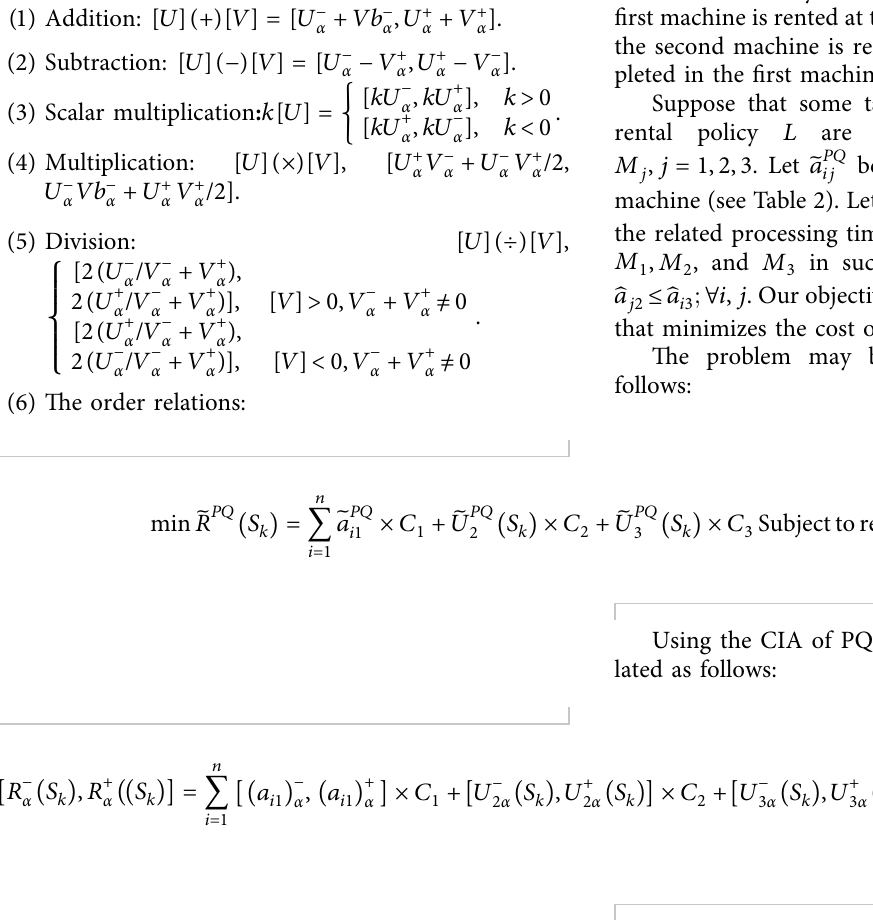
Table 2 may be recreated in CIA of PQFN format as shown in Tables 3 and 4.